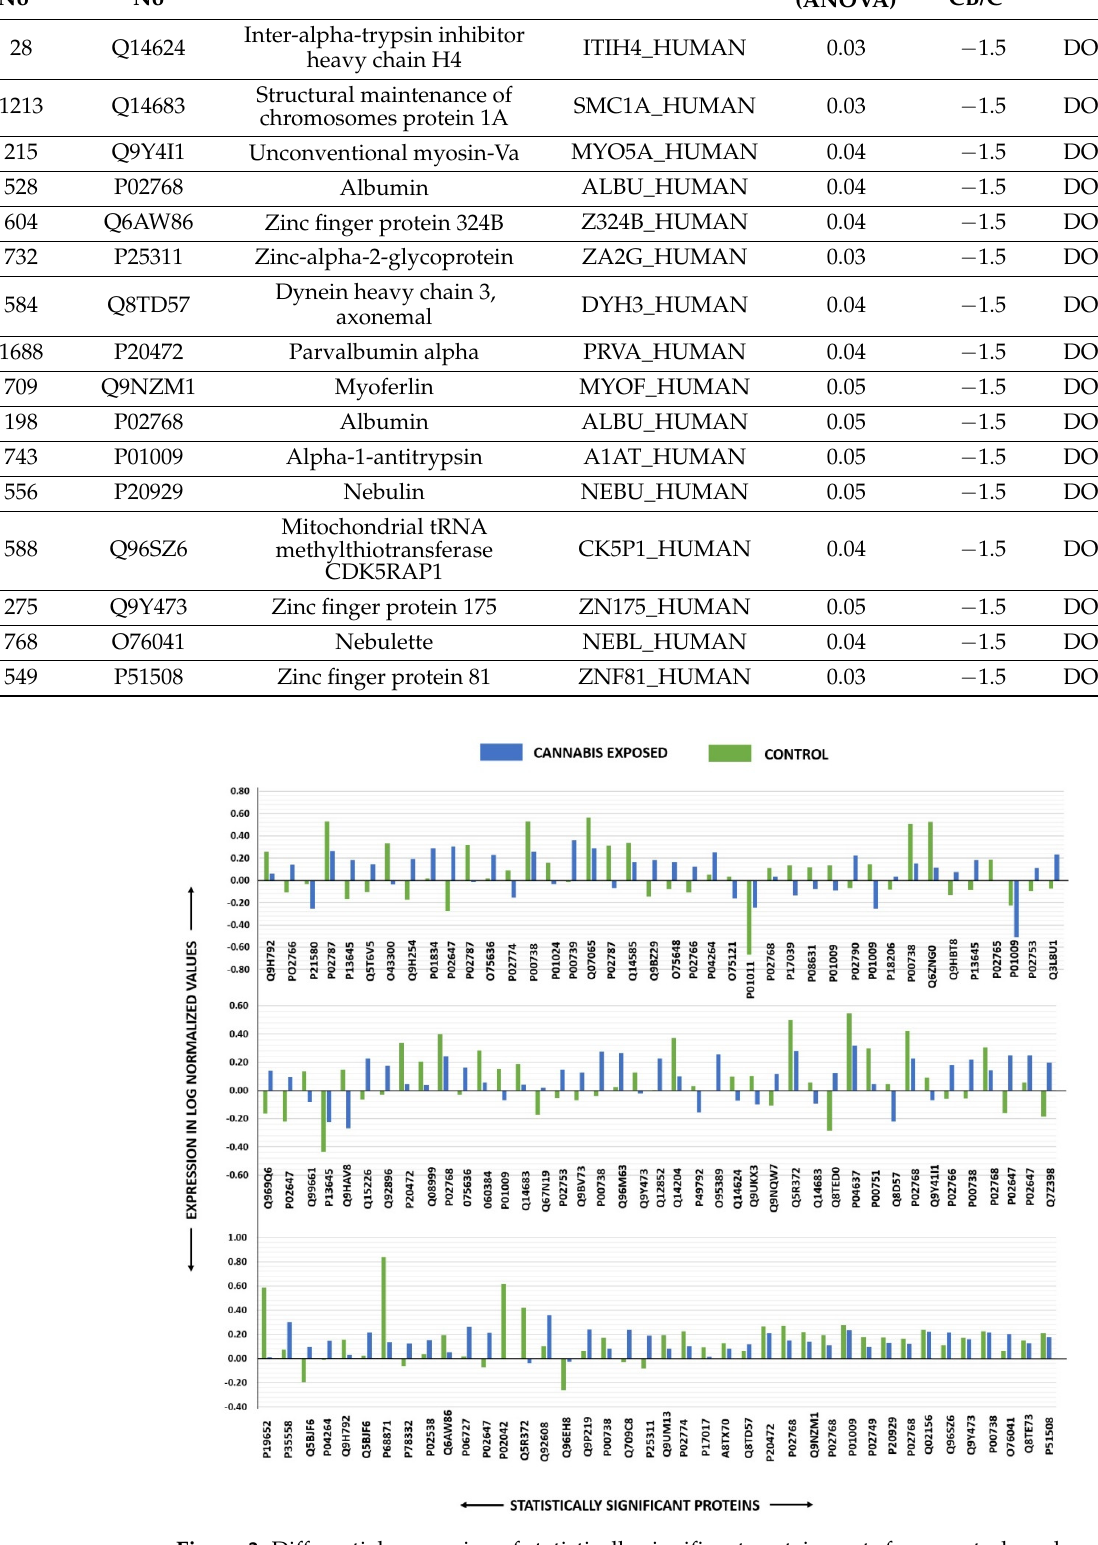
Figure 3 . Differential expression of statistically significant protein spots from controls and cannabis-exposed samples.